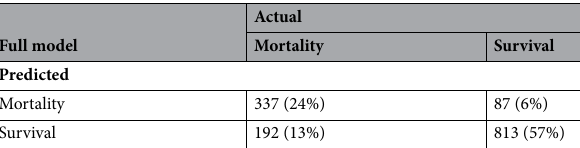
Table 2. Confusion matrix for model predictions of colony-level honey bee overwintering survival for the full Random Forest